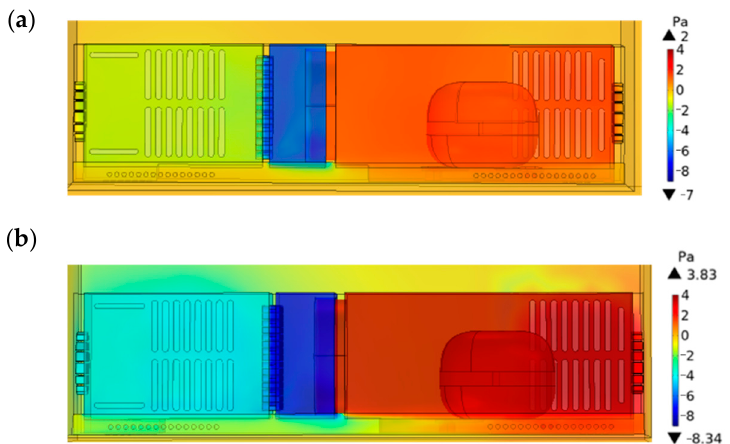
Figure 5. Pressure contours of the compressor chamber for two configurations: ( a ) free-standing and ( b ) ( b ) built-in.